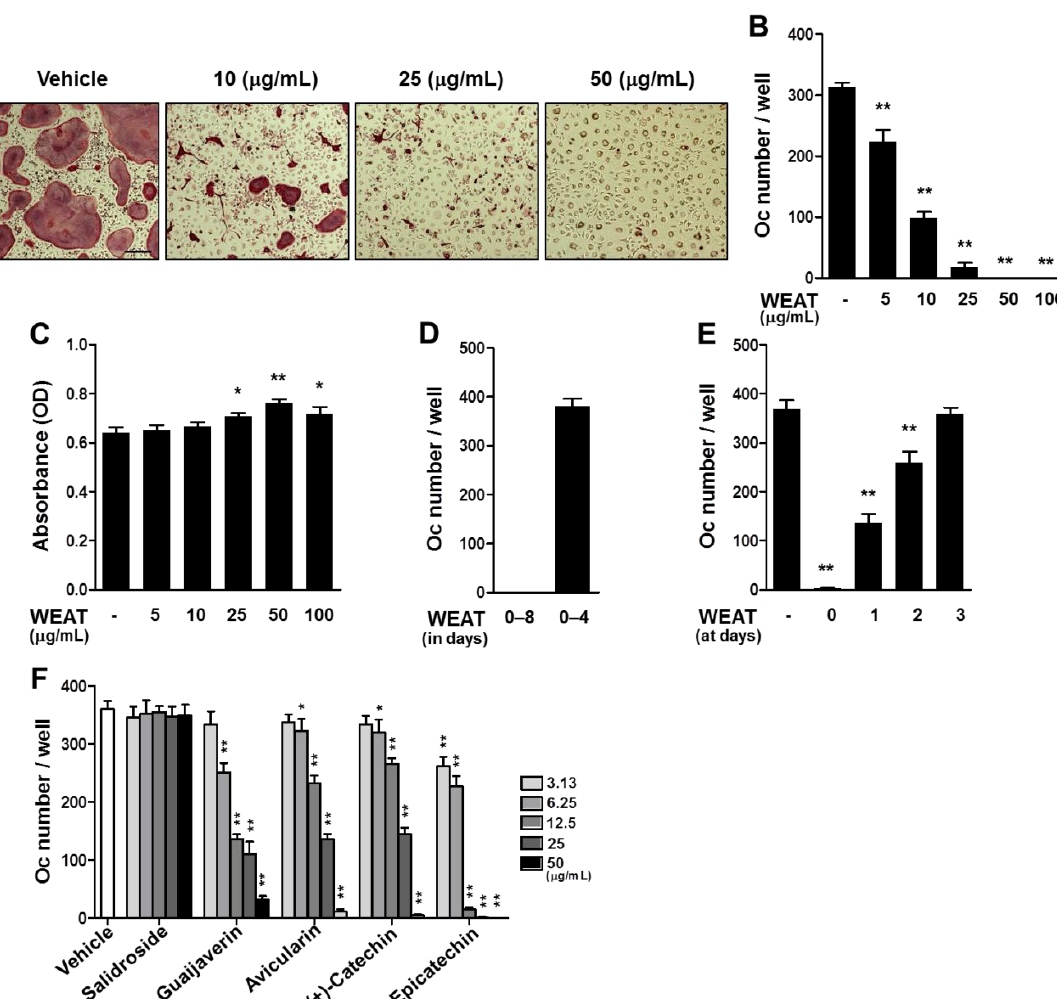
Figure 1. Effect of WEAT on RANKL-induced osteoclast differentiation in BMMs. ( A , B ) BMMs were cultured with vehicle (distilled water) or WEAT in the presence of M-CSF (60 ng/mL) and RANKL (100 ng/mL) for 4 days. ( A ) Cells were fixed and stained for TRAP. Scale bar represents 200 μm. ( B ) The number of osteoclasts (Oc) was counted. ( C ) The viability of BMMs was determined by Cell Counting Kit-8 assay in the presence of M-CSF and WEAT. ( D ) BMMs were cultured with WEAT (50 μg/mL) in the presence of M-CSF and RANKL, and WEAT was kept in the culture or withdrawn on day 4 by medium change. The number of osteoclasts was counted on day 8. ( E ) BMMs were cultured in the presence of M-CSF and RANKL for 4 days. WEAT was added to the medium at the indicated days, and the number of osteoclasts was counted on day 4. ( F ) BMMs were cultured with vehicle (dimethyl sulfoxide) or the indicated compounds in the presence of M-CSF and RANKL for 4 days, and the number of osteoclasts was counted. * p < 0.05; ** p < 0.01 versus vehicle-treated